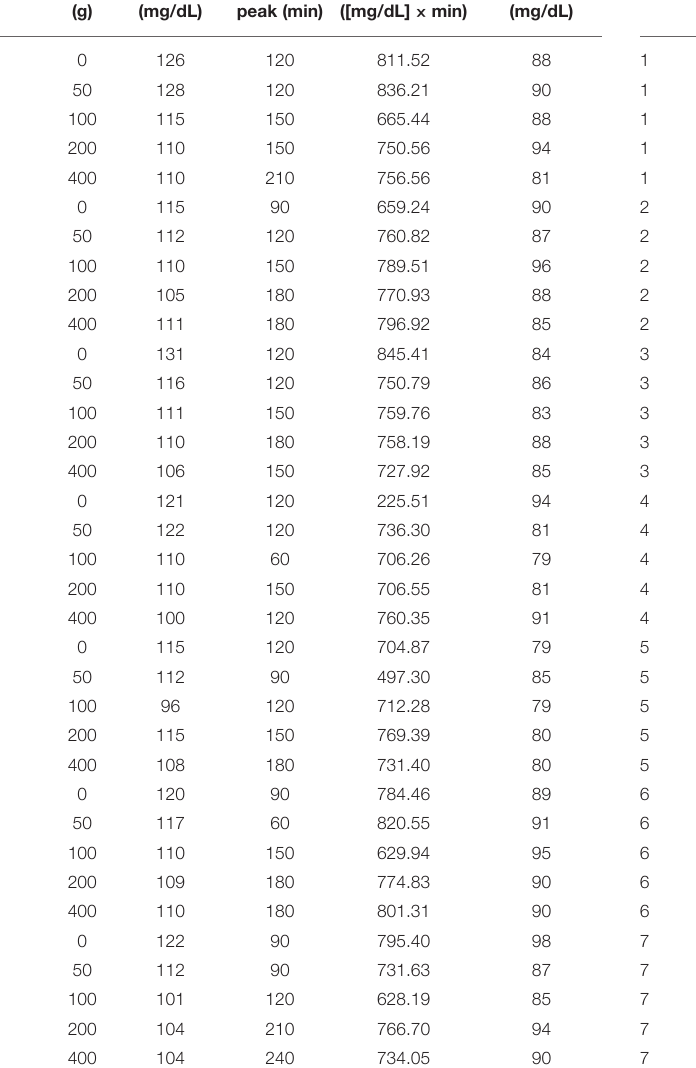
TABLE 4 | Insulin values per horse and aleurone dose. Horse Dose Peak value (g)